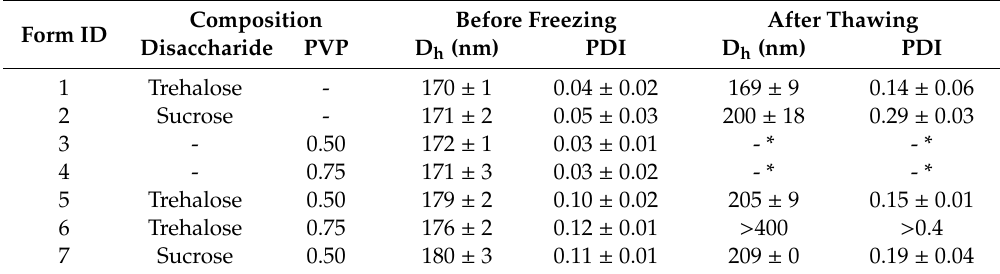
Table 2. Hydrodynamic diameter (D H ) and polydispersity index (PdI) of liposomes prepared by thin-film hydration methods after thawing in the presence of di ff erent excipients or their combinations: Disaccharide and DPPC were in a 5:1 molar ratio. PVP was added in di ff erent percentages, m / v.